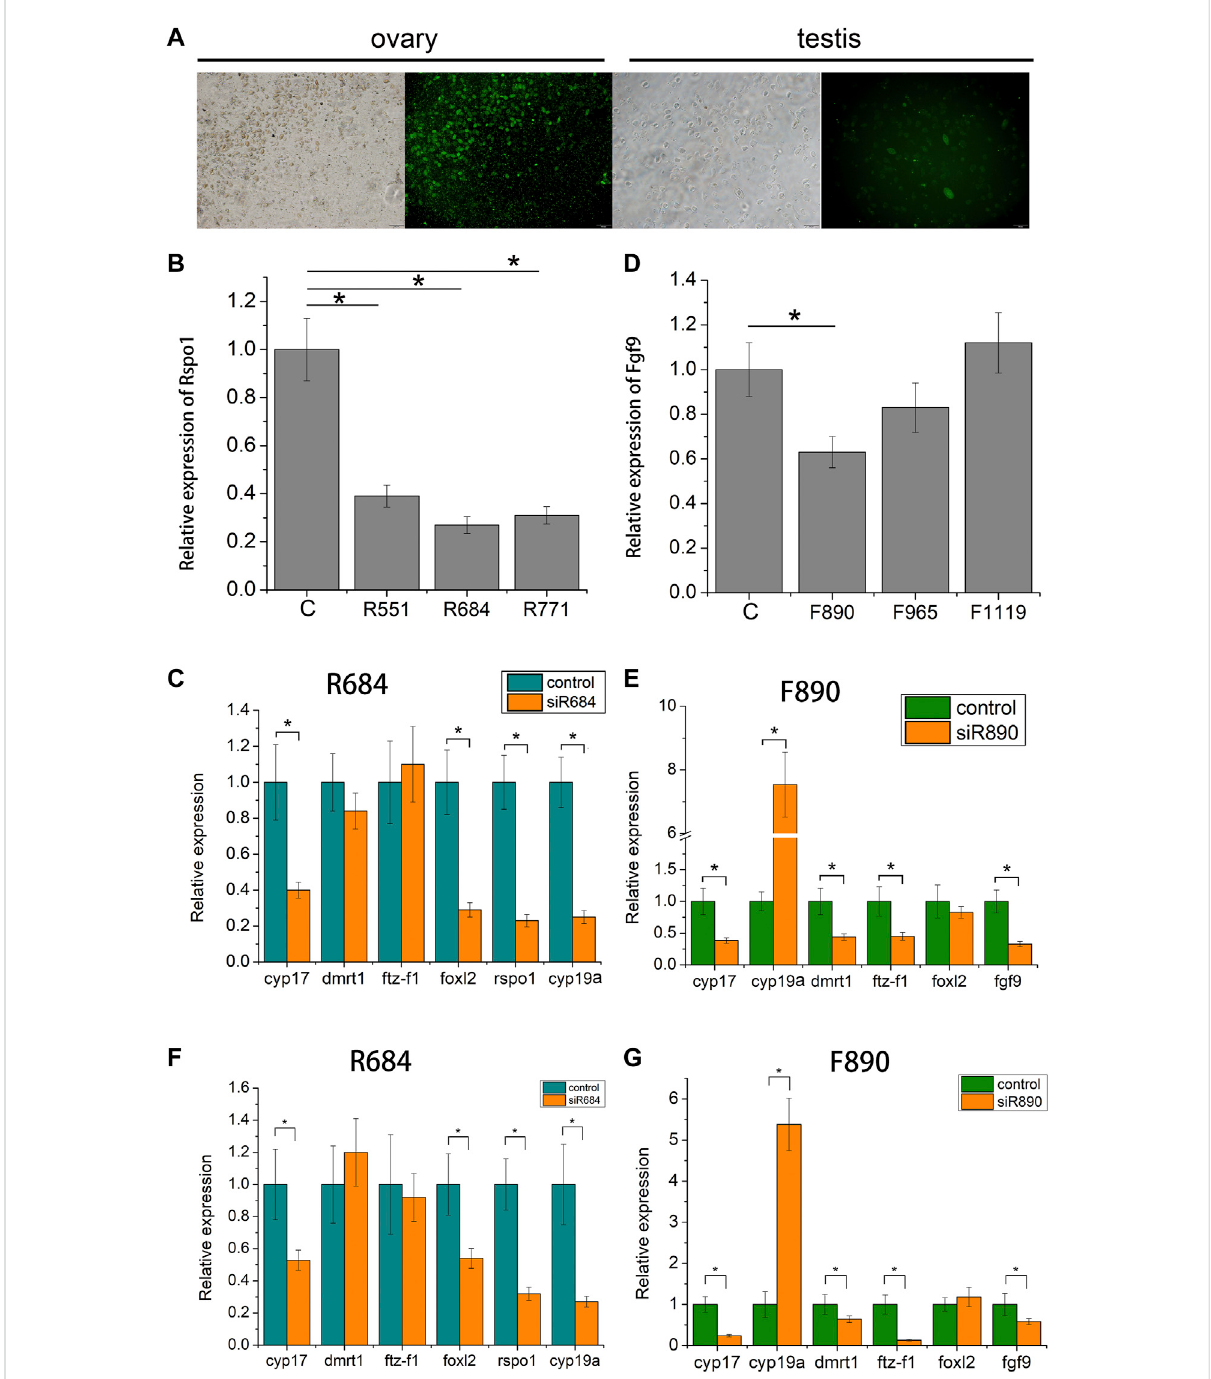
FIGURE 5 Expressionpro fi lesofsex-relatedgenein Andriasdavidianus gonadaftersiRNAtreatment. (A) controlsiRNAmarkedbyFAMtransfectedintothe gonadal cells; (B) Expression level of each rspo1 siRNA sites in ovary cell; (C) expression pro fi le of sex-related genes after R684 treatment in ovary cell; (D) expression level of each fgf9 siRNA sites in testis cell; (E) expression pro fi le of sex-related genes after F890 treatment in testis cell; (F) expression pro fi le of sex-related genes after R684 treatment in ovary tissue; (G) expression pro fi le of sex-related genes after F890 treatment in testis tissue. The results from three replicates and *indicate the signi fi cantly difference ( p <